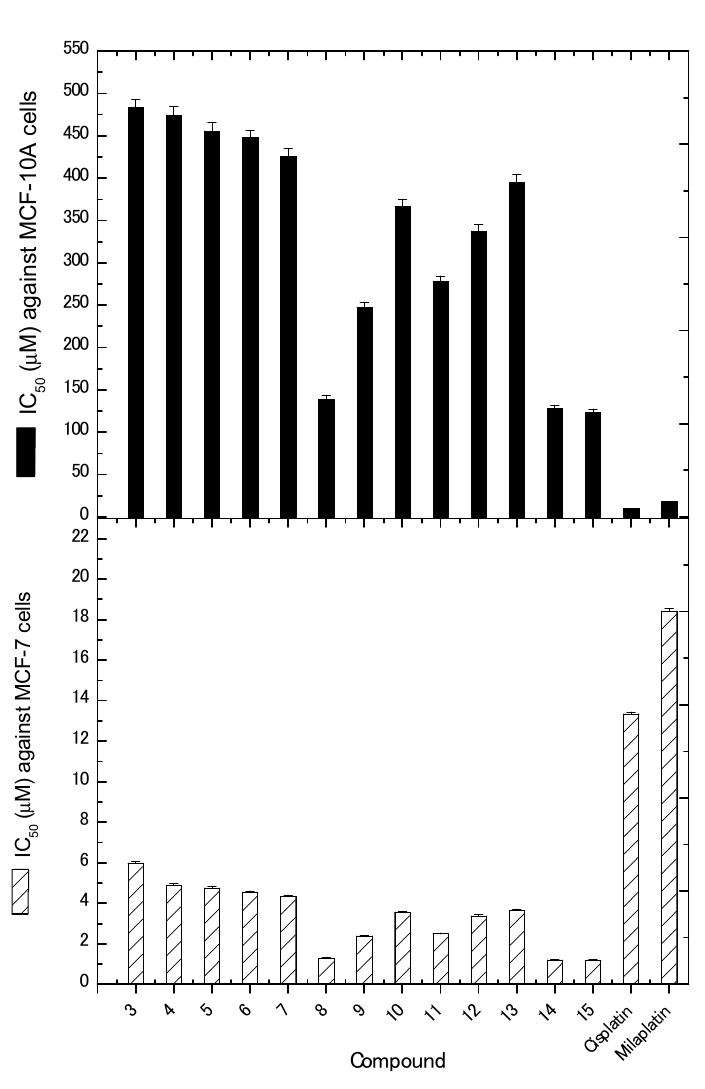
Figure 1. Obtained IC 50 values for MCF-7 and MCF-10A cells.